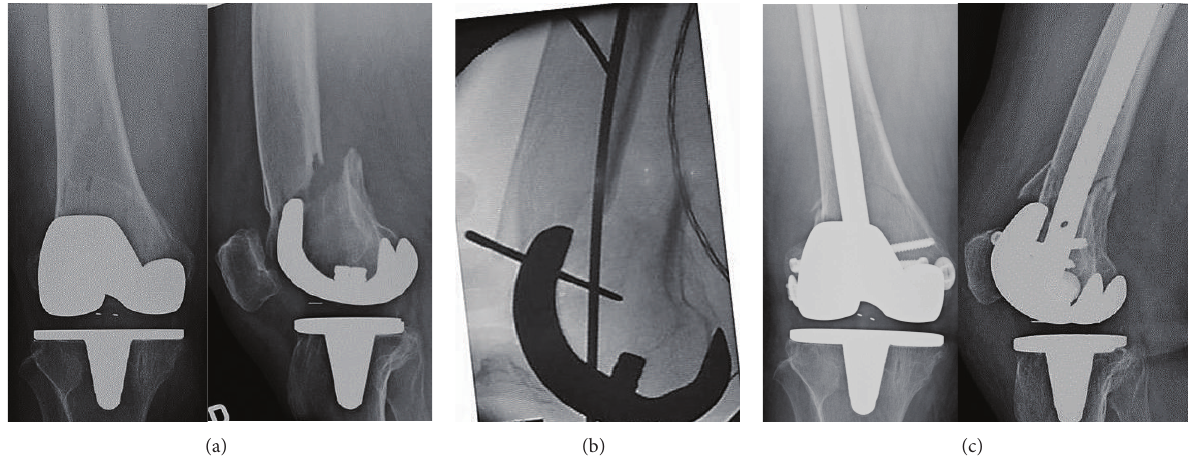
Figure 2: (a) Radiographs of a fracture located proximal to the right femoral component of TKA. (b) On the lateral side, 2.4 mm blocking pins inserted into the distal and proximal fragments. (c) Acceptable reduction and fixation of the fracture with a nail.